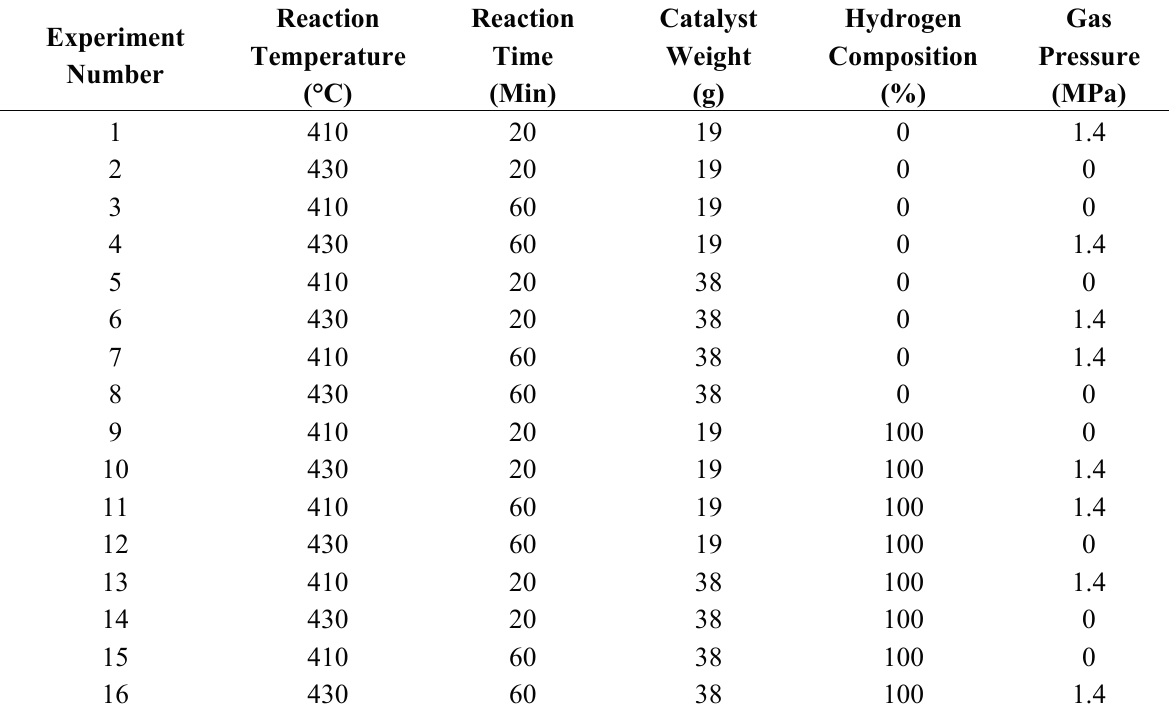
Table 1. Design of Experiments (DOE) reaction conditions for the catalytic cracking of soybean